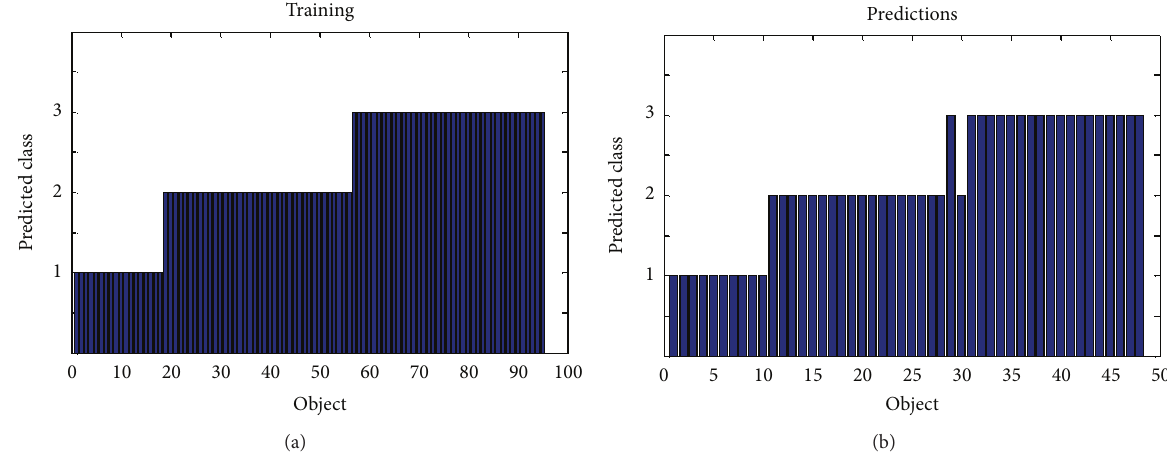
Figure 3: PLSDA training (objects 1–18, class A; objects 19–55, class B; objects and 56–95, class C) and prediction (objects 1–10, class A; objects 11–28, class B; and objects 29–48, class C) of the specific Longjing geographical origins. The height of a bar indicates to which class an object is assigned by